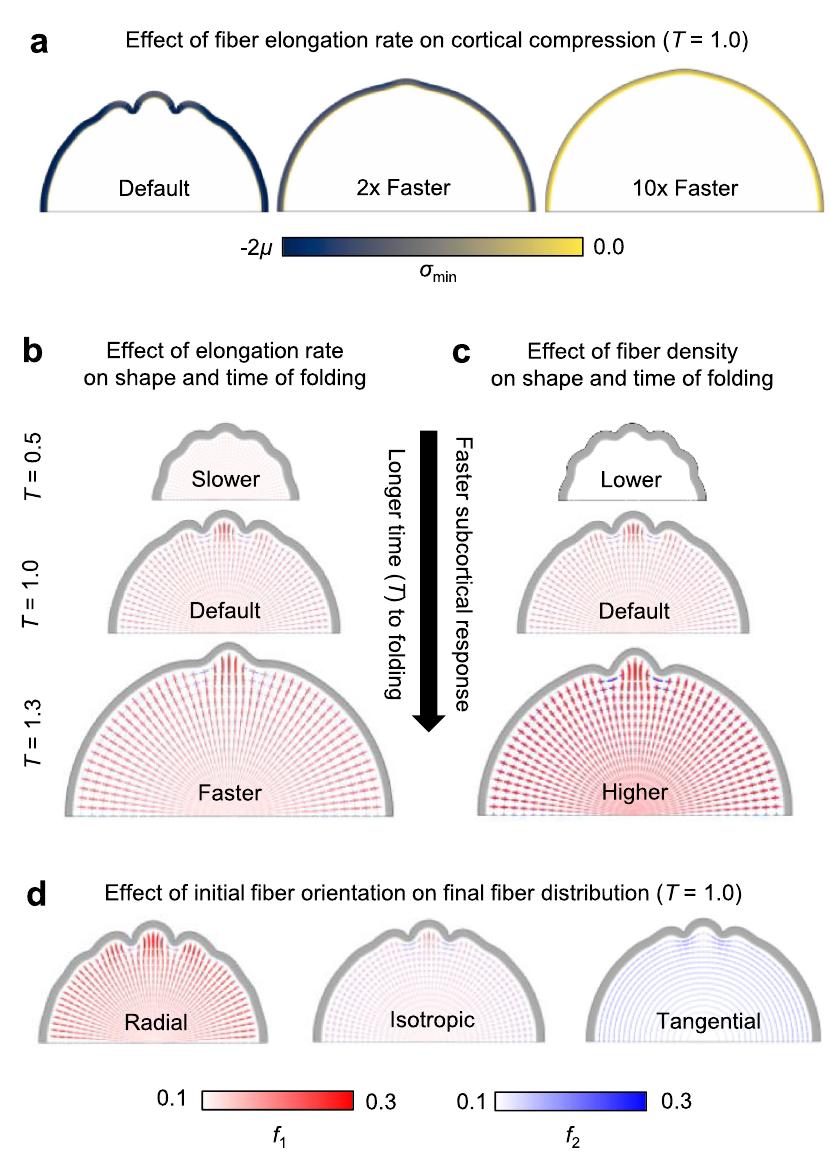
Fig. 3 Effect of initial fi ber properties on cortical folding and fi nal fi ber organization. a Increasing the rate of stress-dependent fi ber elongation results in reduced cortical compression and folding at the fi nal simulation time, T = 1. From left to right, results are shown for nondimensionalized fi ber response ratios R = 60 (default), 120, 600. Colormap indicates the magnitude of minimum Cauchy stress ( σ min ) at each point in the cortical layer, over a compressive stress range of − 600 Pa to 0. ( μ = 300 Pa represents shear modulus of tissue, as de fi ned in Methods.) No folding is observed in models with R ≥ 600. b – c Rate of fi ber elongation and initial fi ber density alter the time course and morphology of cortical folding. From top to bottom in b , results are shown for nondimensionalized fi ber response ratios R = 30, 60 (default), 120. From top to bottom in c , results are shown for total fi ber volume fractions f + f + f = 0.16, 0.32 (default), 0.64. For each case shown, the selected simulation time ( T ) was chosen to illustrate morphology and fi ber volume 1,0 2,0 3,0 fractions at a similar stage of fold maturity. d Initial fi ber organization produces subtle in fl uence on fi nal fold morphology but similar subcortical fi ber organization with respect to gyri and sulci. In b – d , crosses ( + ) are used to visualize local fi ber volume fraction in terms of radial ( f 1 ) and tangential ( f 2 ) directions. Magnitude of fi ber volume fraction in speci fi c directions is represented by color (radial fi bers in red, tangential fi bers in blue), such that a dark red region indicates increased radial fi bers per unit volume, dark blue indicates increased tangential fi bers per unit volume, and light color indicates relatively low fi ber volume